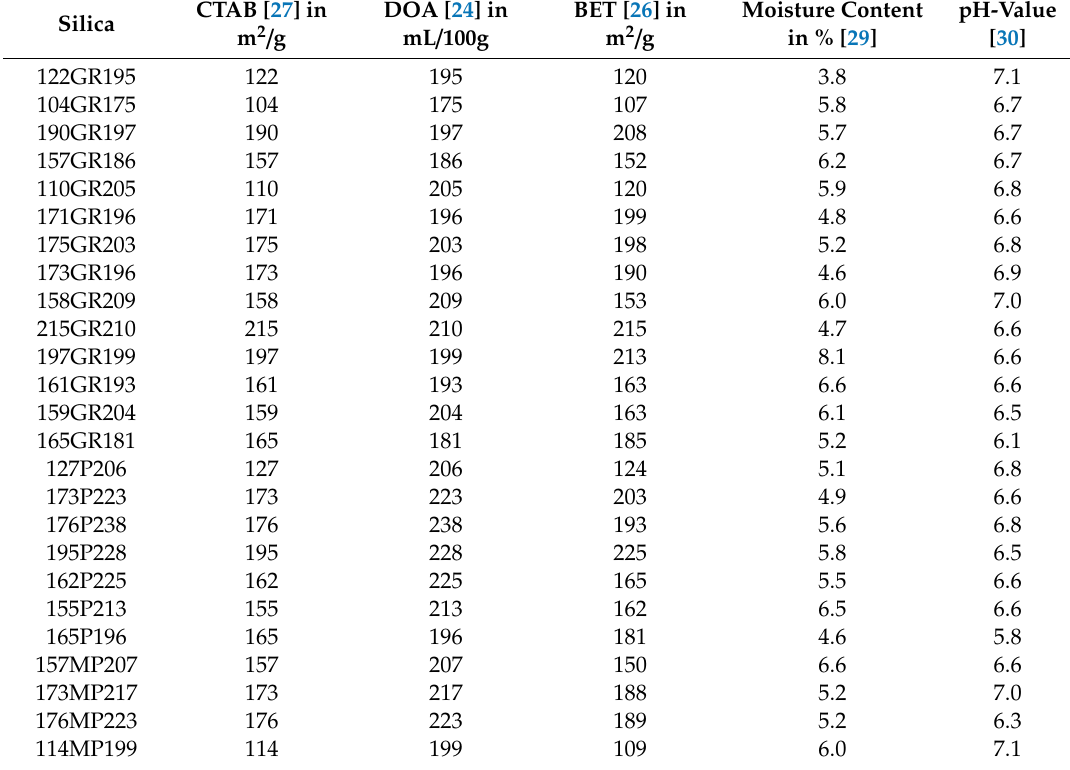
Table 1. Twenty five di ff erent types of silica and their five standard analytical